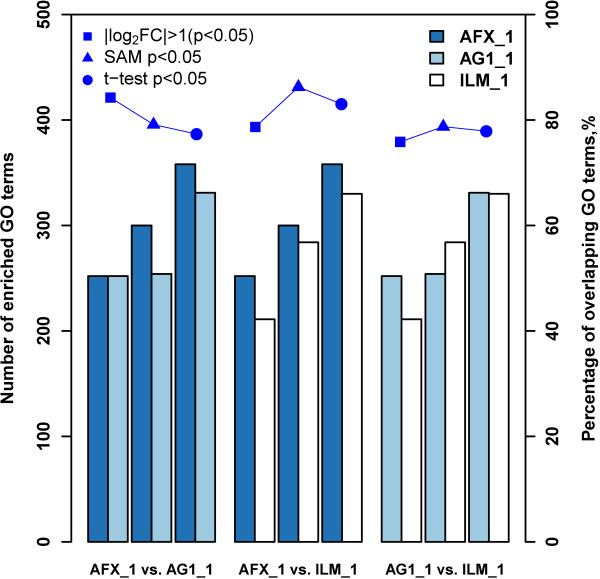
Inter-platform concordance of significant GO terms enriched by GSEA. The left y-axis represents the number of enriched GO terms by using GSEA for each of the platforms, and the right y-axis is the percentage (%) of overlapping GO terms. The number of overlapping GO terms of each platform are presented in a series of bars which correspond to the left scale. Scatter plots represent the percentages of overlapping GO terms of two platforms which correspond to the right scale. The blue, lightblue and white barplots represent the number of significantly enriched GO terms (FDR < 0.25) of AFX_1, AG1_1 and ILM_1, respectively. Different markers represent different DEG selection methods and their cutoff. The _1 suffixe refers to test site.